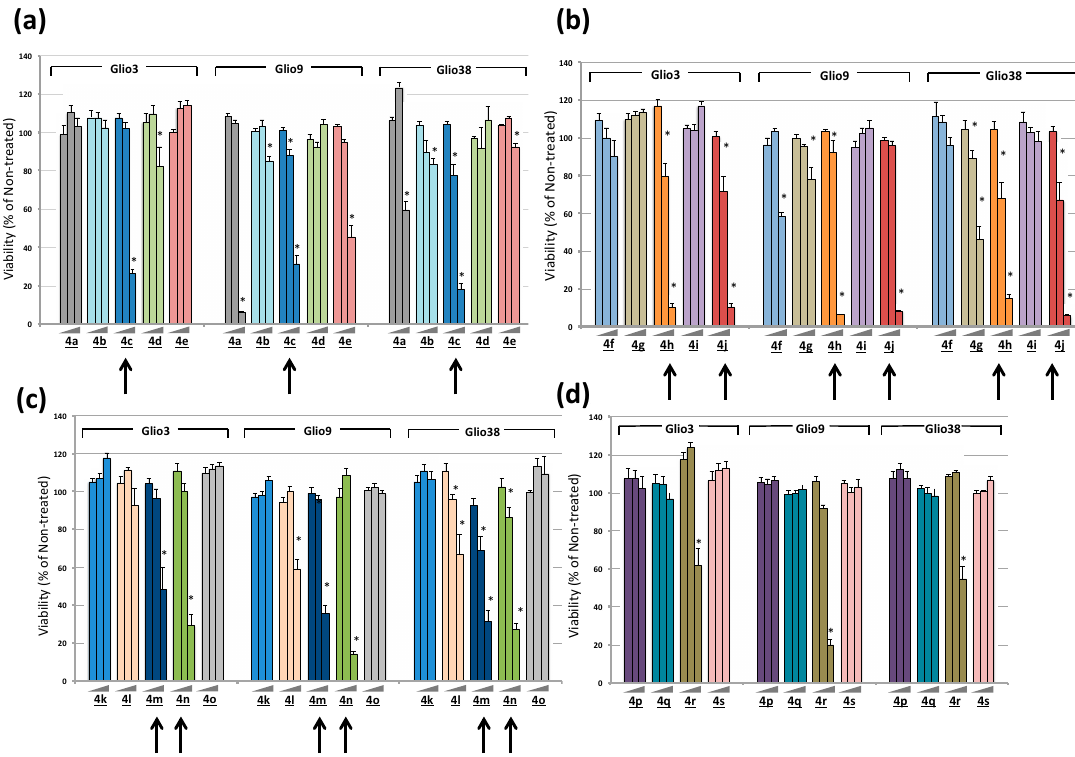
Figure 2. Bis-chalcones reduce GSC viability. GSC lines Glio3, Glio9 and Glio38 were treated with 0.1 µ M, 1 µ M, or 10 µ M of each bis-chalcone analog and viability determined by MTS assay. The data is presented as percent viability compared to non-treated controls. * p < 0.05, compared to non-treated controls. Arrows indicate bis-chalcones that reduced viability over 50% at the 10 µ M in all three GSC lines. ( a ) bis-chalcones 4a–4e; ( b ) bis-chalcones 4f–4j; ( c ) bis-chalcones 4k–4o; ( d ) bis-chalcones 4p–4s.